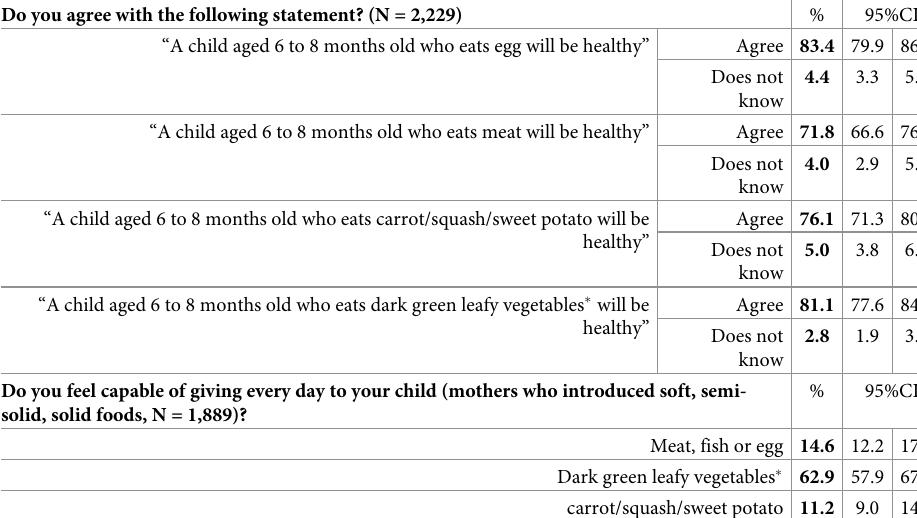
Table 5. Attitudes and perceived self-efficacy towards child complementary feeding. Do you agree with the following statement? (N = 2,229)